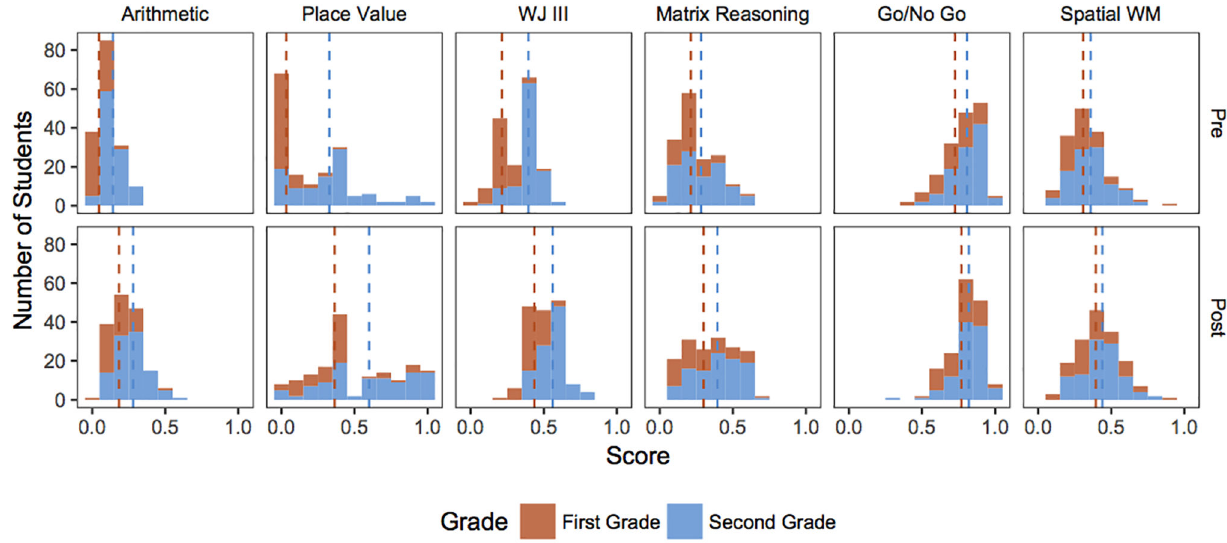
Figure 2. Histograms showing the distribution of scores from each task in our battery, split by grade level. Dashed lines show means. Upper panels show pre-test scores; lower panels show post-test